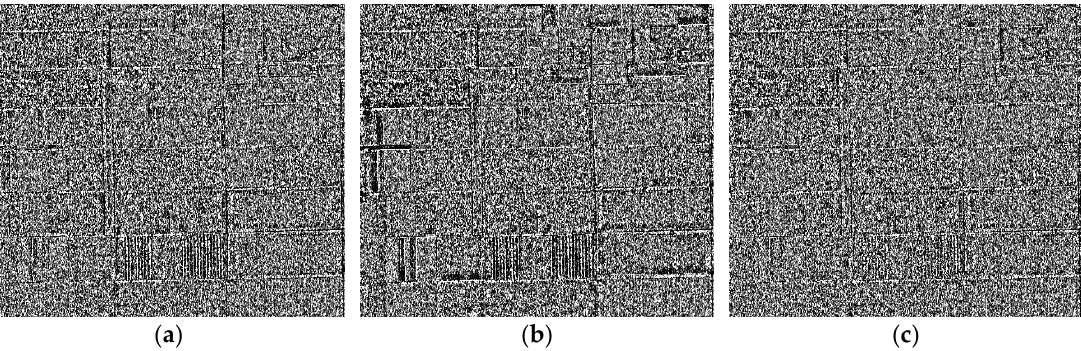
Figure 7. The ratio images of the different superpixel segmentation algorithms for the AirSAR PolSAR image: ( a ) GMS segmentation, with N r = 7449; ( b ) Ncut segmentation, with N r = 8064; and, ( c ) SLIC-GC segmentation, with N r = 7728. Table 1. Means and variances of the ratio images for the different superpixel segmentation algorithms with the AirSAR image.